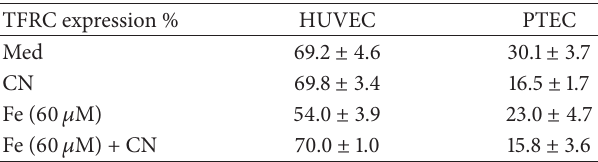
Table 1: TFRC expression under different conditions in either HUVECs or